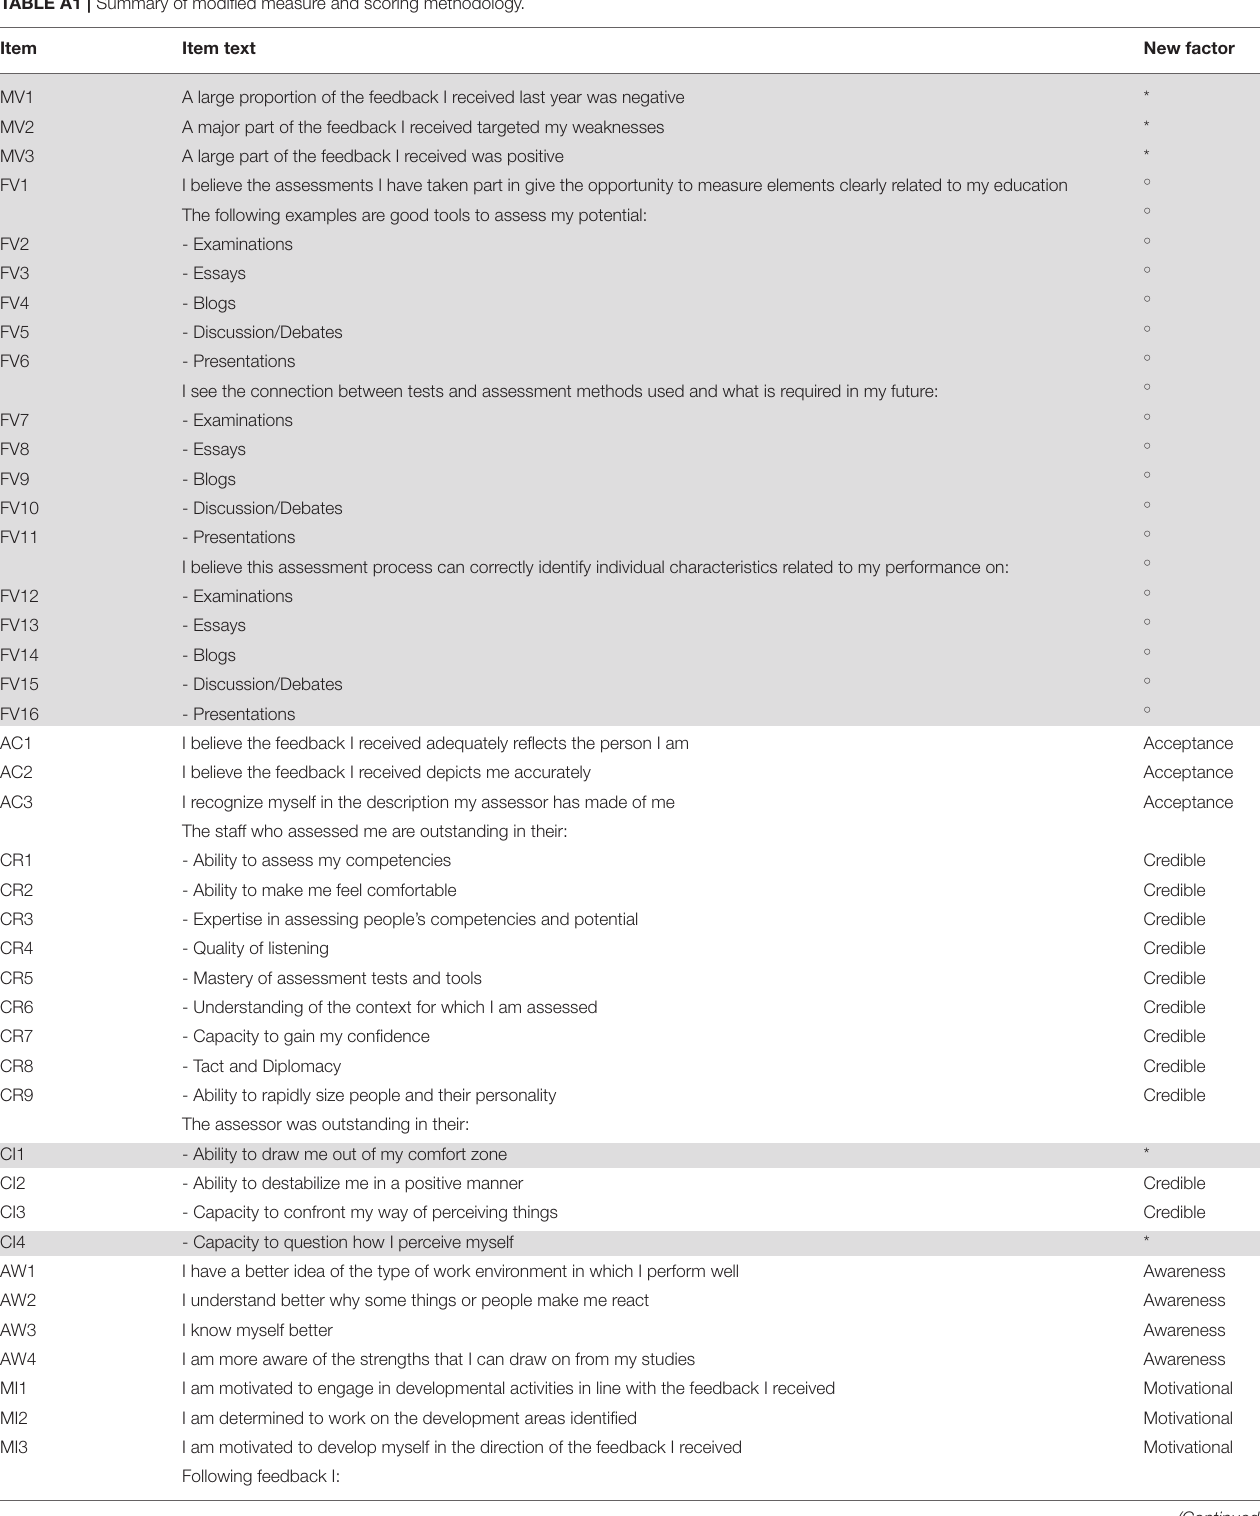
TABLE A1 | Summary of modified measure and scoring